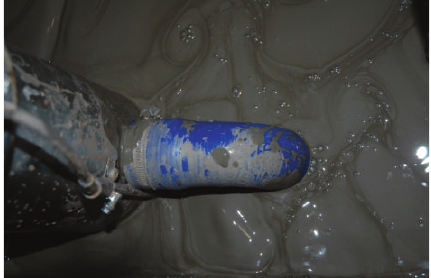
Figure 7: The picture of drilling mud containing gas, drilling mud from Sowia G´ora